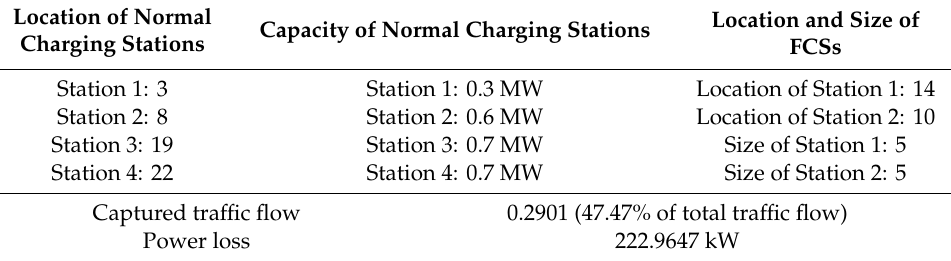
Table 5. Result of the selected solution.